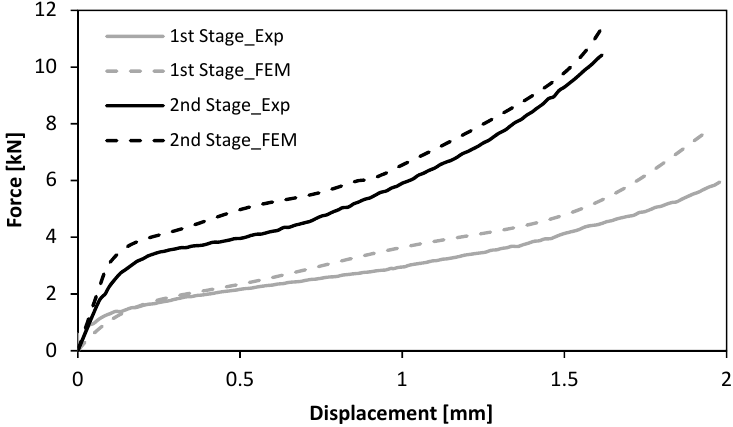
Figure 7. Experimental and numerical evolution of the force with displacement for the first and second stages of the sheet-bulk compression of tenons with h = 4.5 mm.